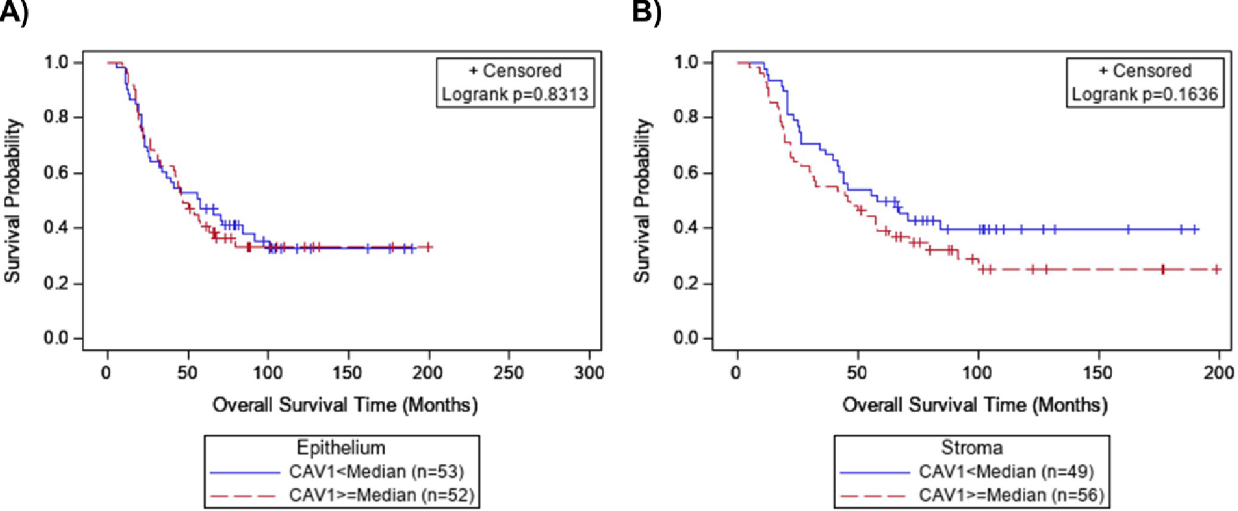
Fig 4. Overall survival of serous ovarian cancer by expression of Cav-1 in Cohort 2. Kaplan-Meier survival curves for Cohort 2 by immunofluorescent expression of Cav-1 in the (A) tumor epithelium and (B) stroma, using the median AQUA 1 score as the cutoff.